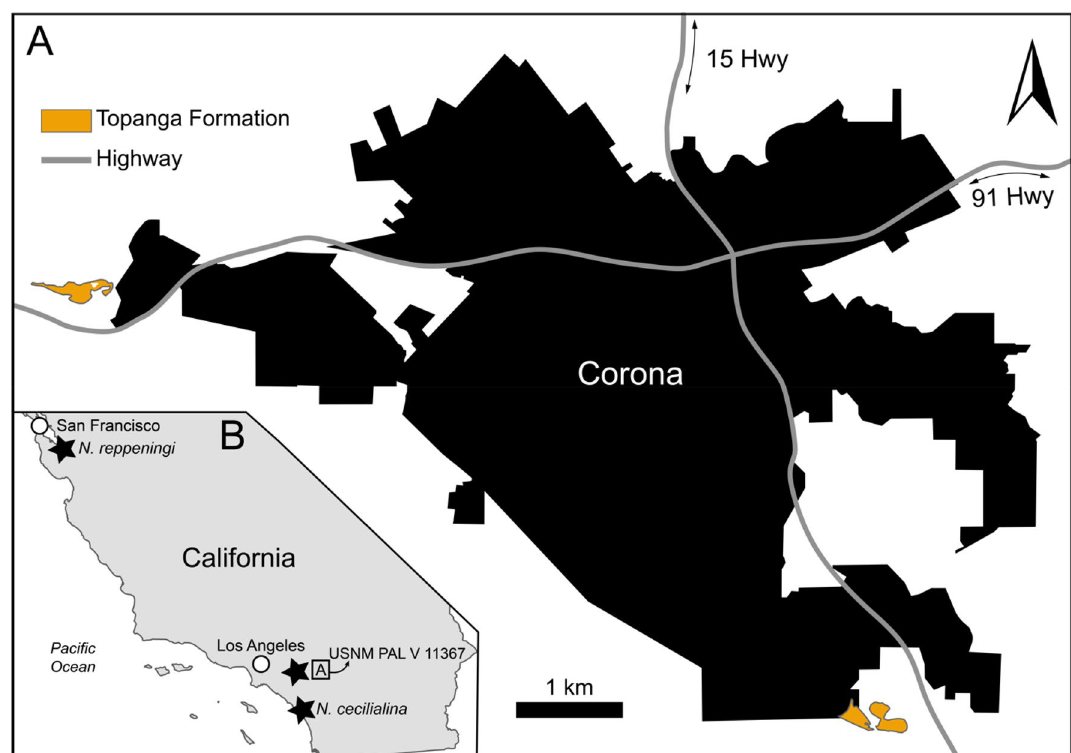
Figure 3. Locality map of Neoparadoxia . ( A ) localities of all Neoparadoxia previously reported and USNM PAL V 11367. This map is dawned based on geological maps published by Gray et al. 24 and Morton et al. 34 ; ( B ) potential localities of USNM PAL V 11367. Orange means distribution area of the “Topanga” Formation in Corona City. The grey line means highways. All figure was created by using Adobe Illustrator (https:// www. adobe.